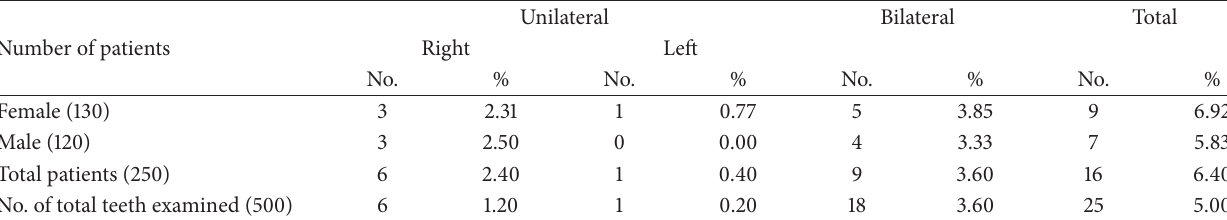
Table1:Numbersandpercentagesofpatientswithmandibularfirstmolarshavinganextradistolingualrootbygender,unilateralandbilateral status, and total